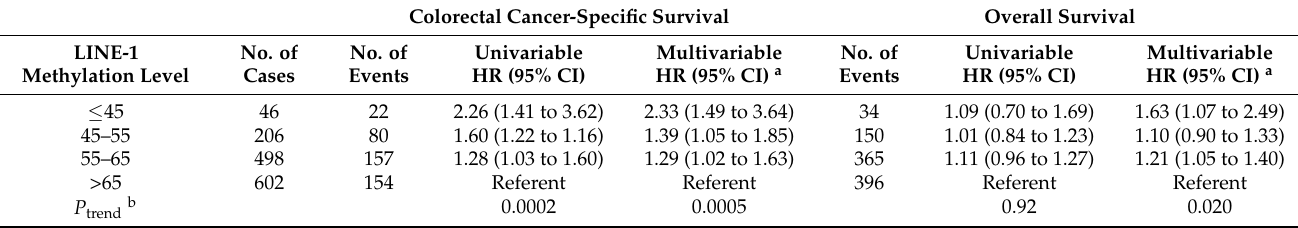
Table 4. Survival of colorectal cancer patients according to tumor LINE-1 methylation